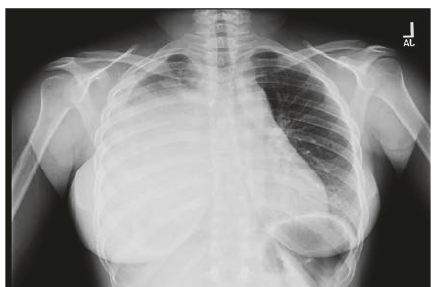
Figure 1: CXR on admission showing large right-sided infiltrate.